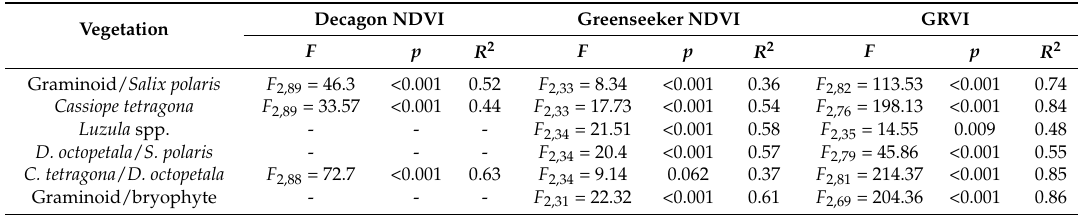
Table 2. Relationships between day of year and values of different vegetation indices in six different High Arctic vegetation types. GRVI values outside the 95% confidence interval of the linear model have been omitted from the analyses to exclude obviously erroneous